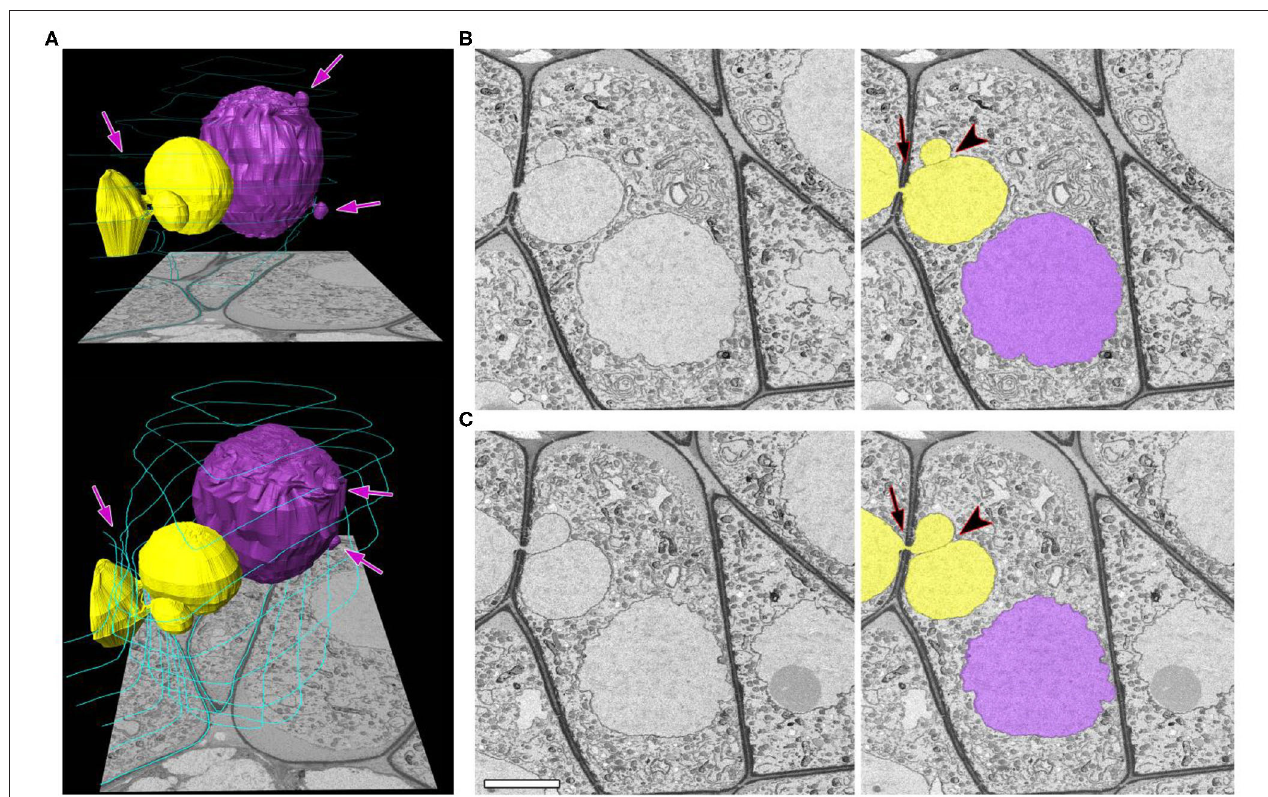
FIGURE 4 | A zygotene meiocyte that has a potential to become binucleated. (A) Three-dimensional reconstructions from 464 serial images of labeled nuclei and cell walls in two views at different angles. (B,C) Original and labeled micrographs with the biggest size of the NPs. Yellow and purple denote individual nuclei (both are involved in the INM), and turquoise represents cell walls, labeled on every 50th slice. The arrows indicate the NPs crossing a cell wall, and the arrowheads point to contact areas between the NPs. The scale bar is 5 µ